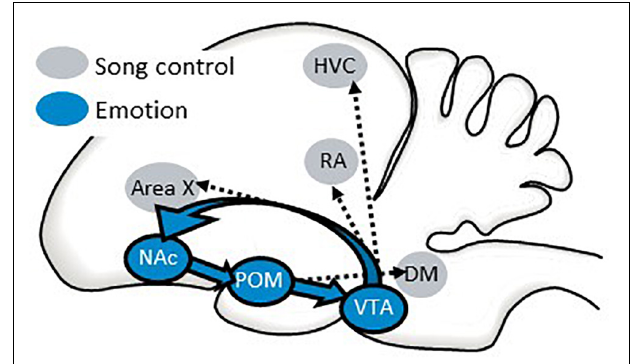
FIGURE 9 | A possible pathway by which the NAc may coordinate an individual’s emotional state with singing behavior. Sagittal illustration of a songbird brain. A circuit from the preoptic area (POM) to the ventral tegmental area (VTA) to the nucleus accumbens (NAc) and back to the POM is proposed to regulate affective states that can influence singing behavior and perception through its projections to song control nuclei. See text for additional details.